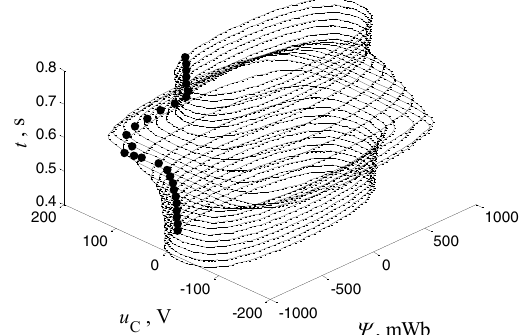
Fig. 2. Phase trajectory of the investigated system (where ferroresonance is observed).